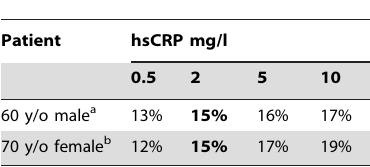
Table 1. Estimated 10 year risk of a heart attack, stroke, or other major heart disease based on the risk calculator at reynoldsriskscore.com.